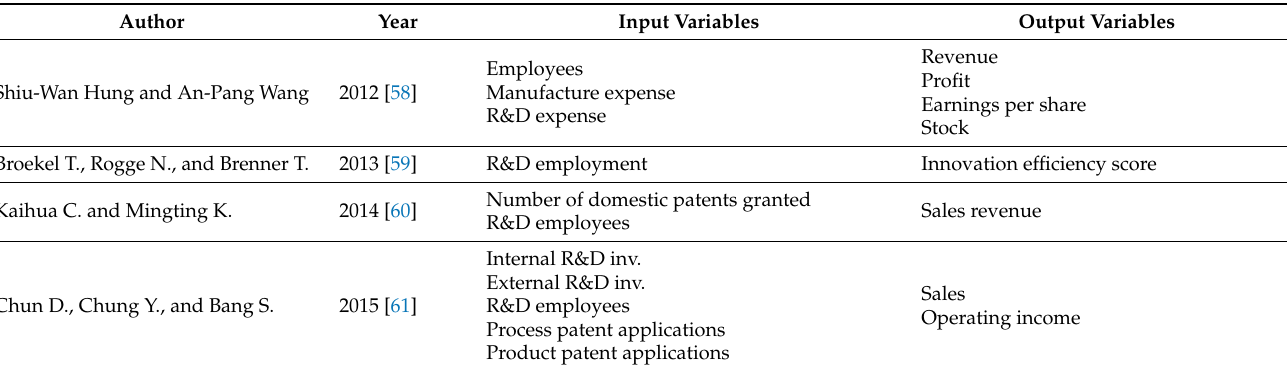
Table 2. Input–output variables used in DEA